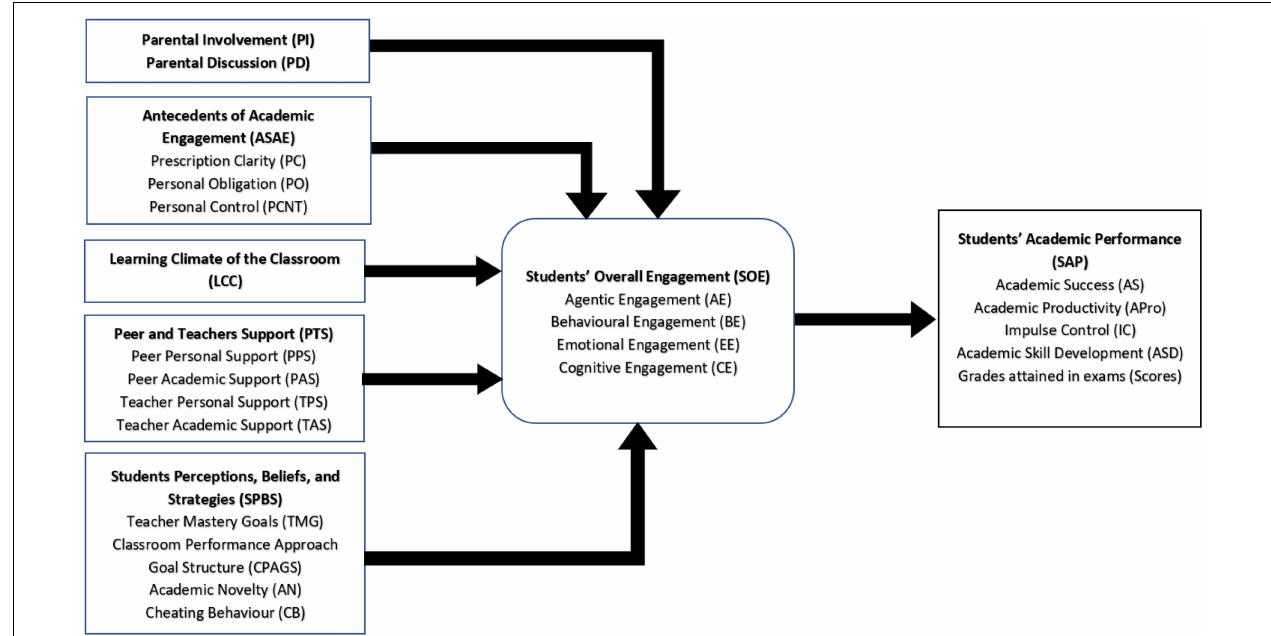
FIGURE 1 | Theoretical